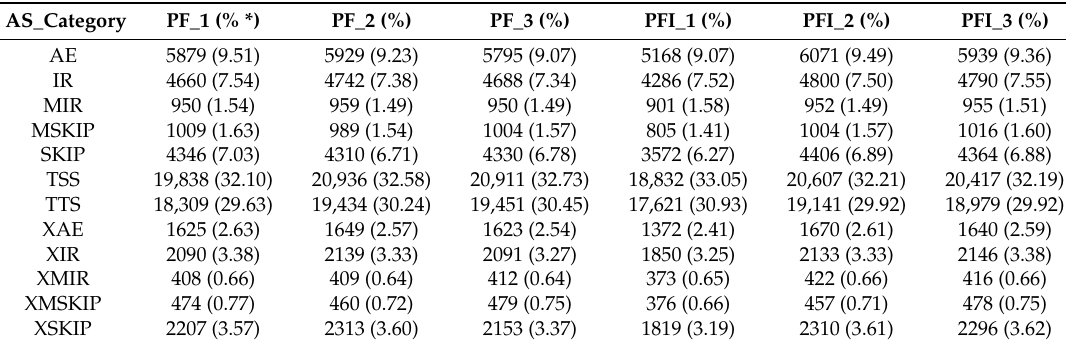
Table 4. Statistic of alternative splicing categories from mRNA